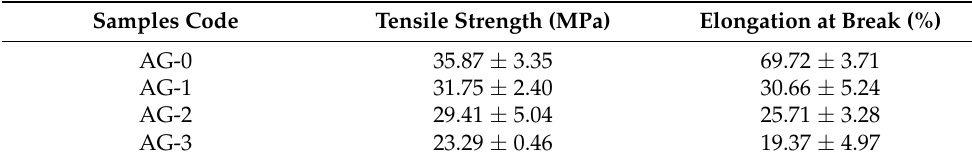
Table 4. Mechanical properties of filler-incorporated systems.